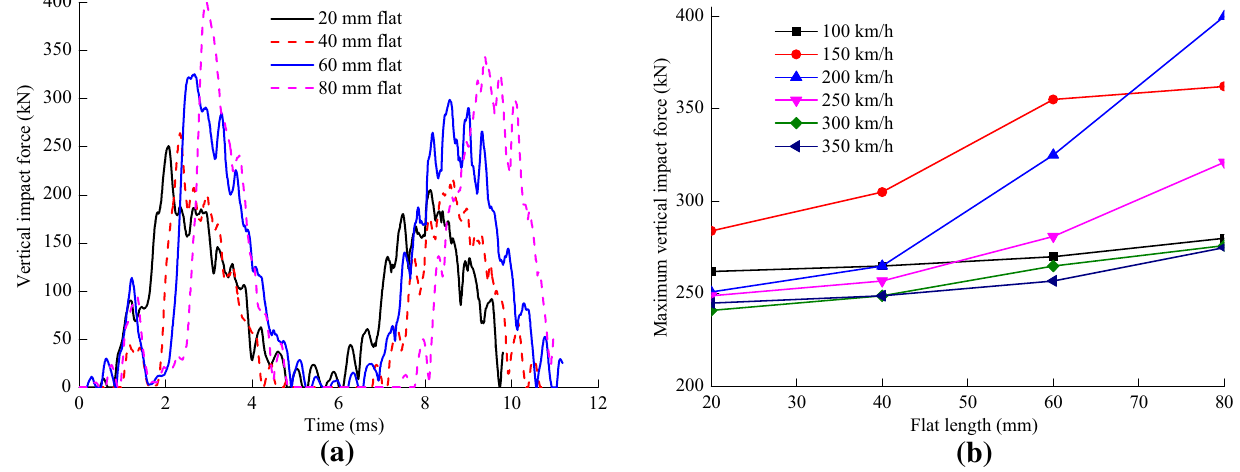
Fig. 9 Influence of flat length on the vertical wheel–rail impact response. a Typical vertical impact force versus time curves. b Maximum vertical impact